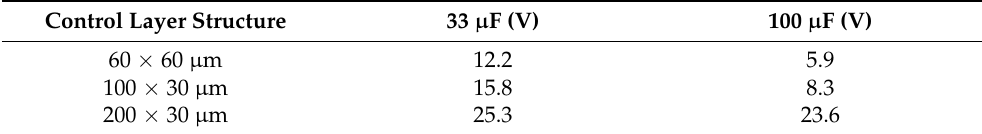
Table 3. Bridge areas of different